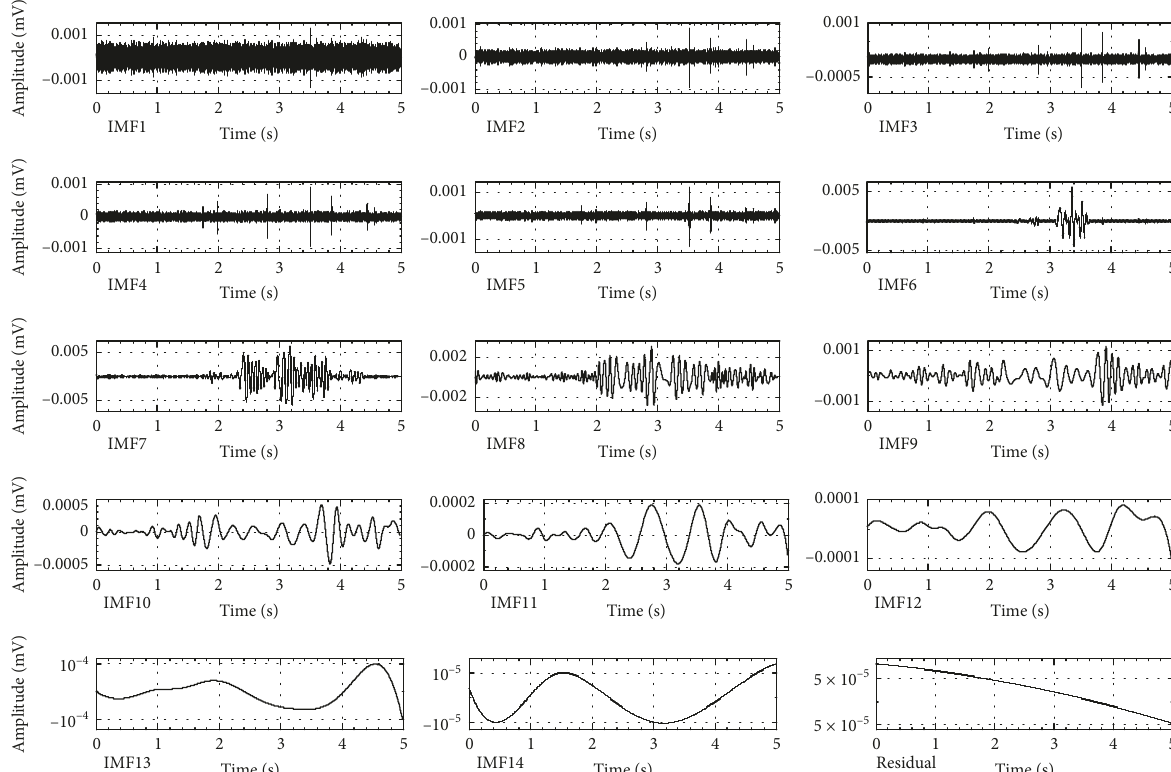
Figure 9: IMF components obtained by EEMD.